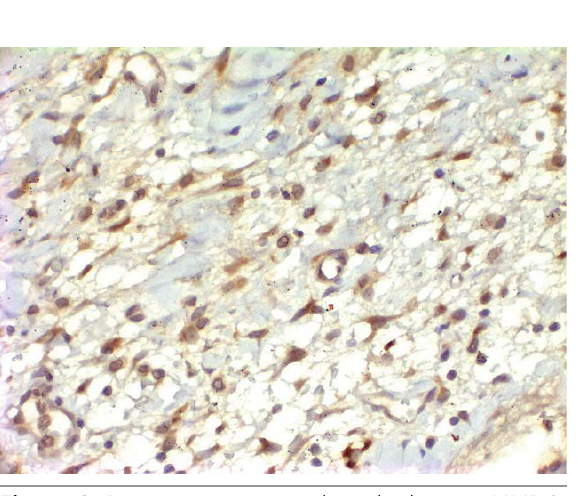
Figure 3. By immunostaining with antibodies anti-MMP-9, MMP-9 positive staining observed in fibroblasts which are showing moderate proliferation. There are quite a few negative staining inflammatory cells mixed with fibroblasts in between. (Immunostaining with antibodies anti-MMP-9, x400) (S-CP group).